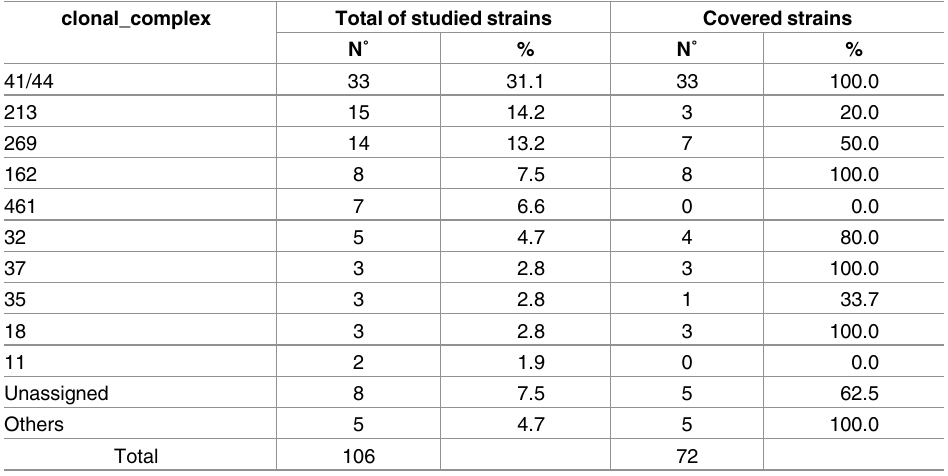
Table 3. Clonal complexes of studied strains and percentage of covered strains predicted by MATS.